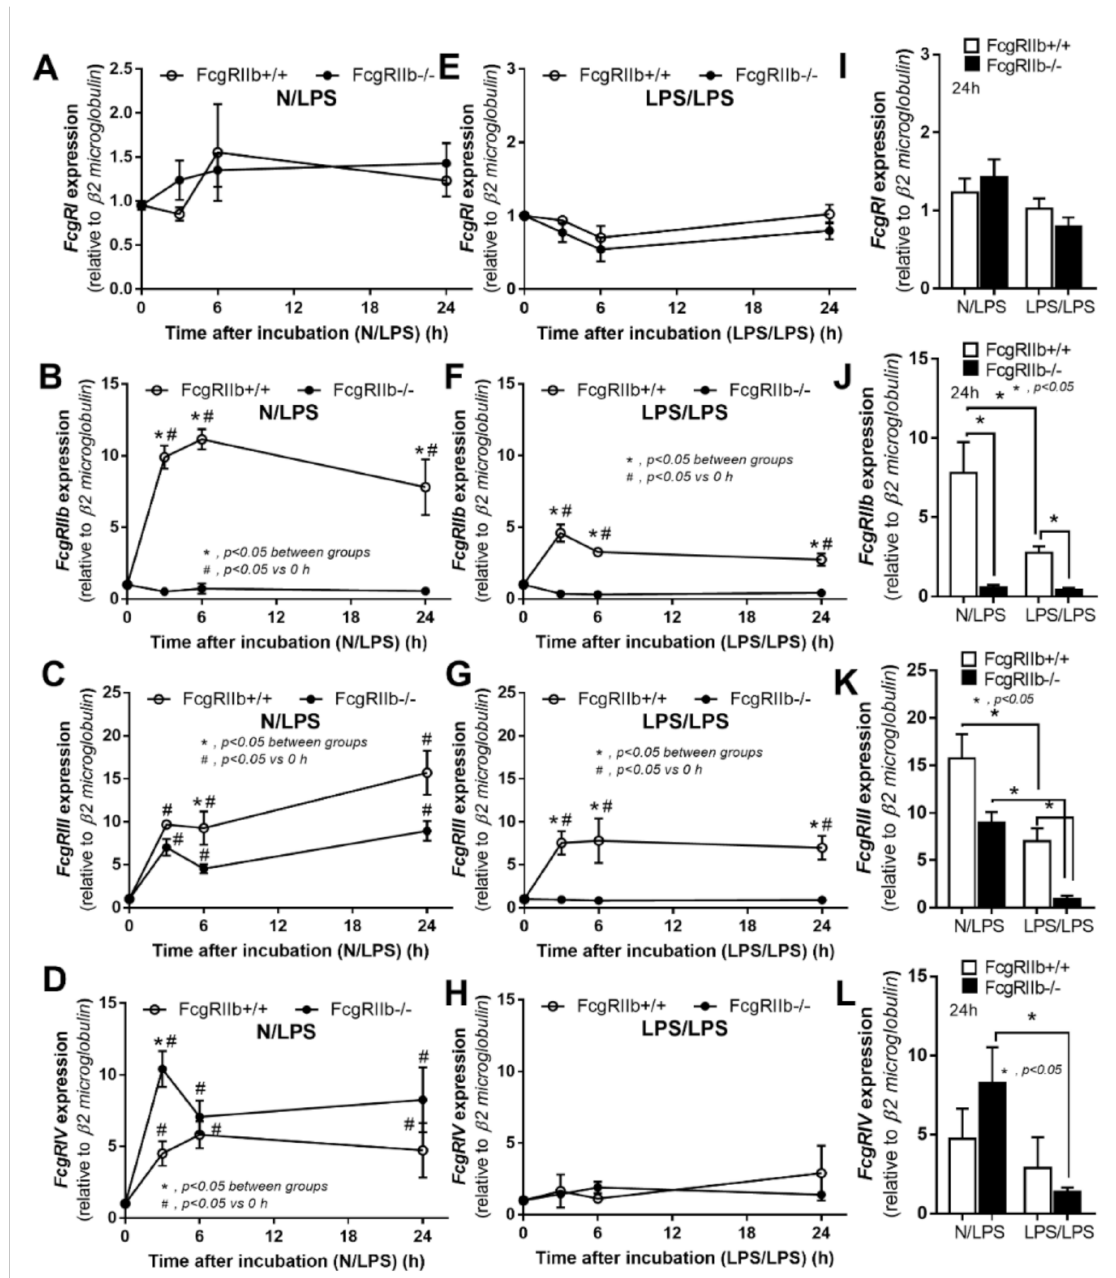
Figure 8. The gene expression by quantitative polymerase chain reaction in macrophages from FcgRIIb-/- lupus mice and wild-type (FcgRIIb+/+) mice after 6 h incubation with a single lipopolysaccharide stimulation (N/LPS) ( A–D ) or stimulation twice (LPS/LPS) ( E–H ) and the presentation in graphs of the 24 h post-stimulation ( I – L ) are demonstrated. Independent triplicate experiments were